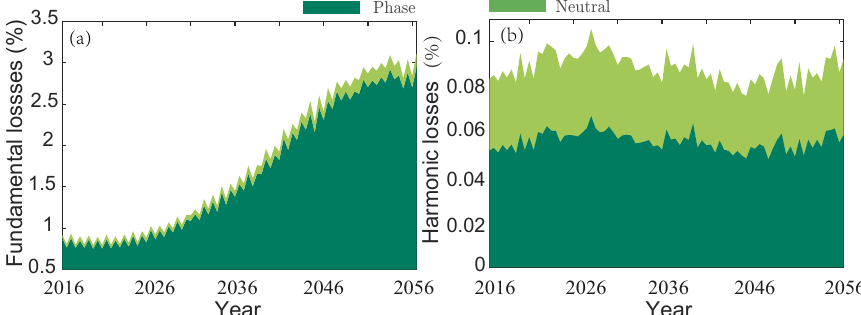
Figure 17. The 95 percentile fundamental and harmonic losses both in the ( a ) phase conductors and ( b ) neutral